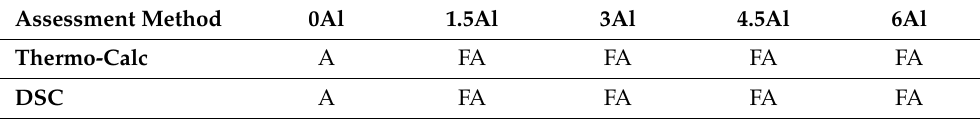
Table 2. Solidification modes based on thermodynamic equilibrium calculations by Thermo-Calc and DSC measurements. A and FA stand for austenitic and ferritic-austenitic solidification modes, respectively. In the latter case, the solidification begins with the formation of primary ferrite and continues with the formation of austenite.